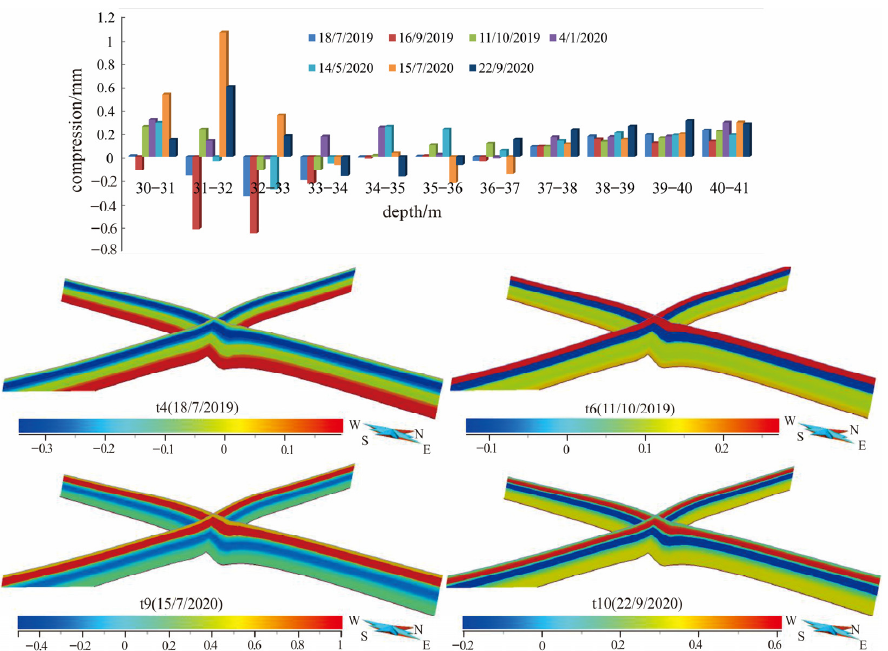
Figure 20. Monitoring data (vertical compression) and a preliminary dynamic model of target units at one monitoring site in the study